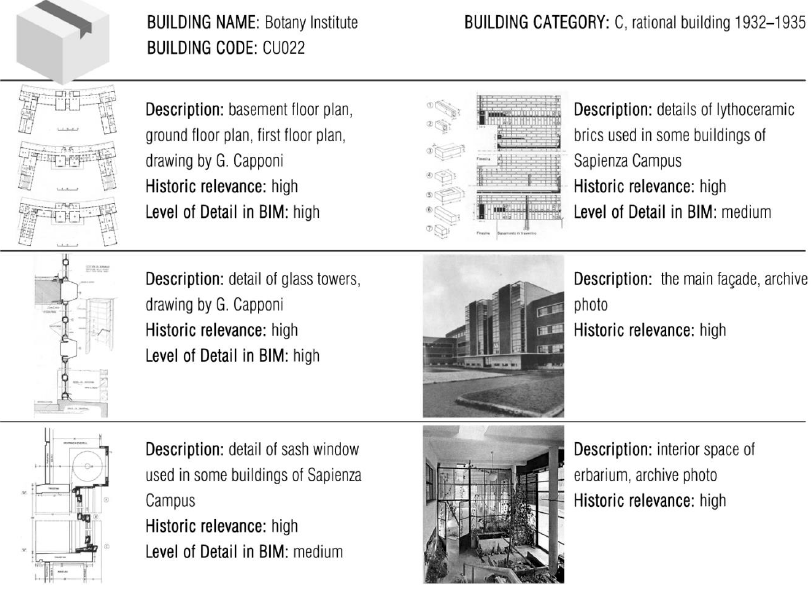
Figure 7. The Botany Institute, views from numerical model derived from 3D integrated survey.